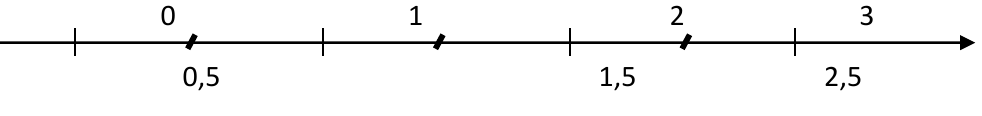
Figure 1. Scale with the values and